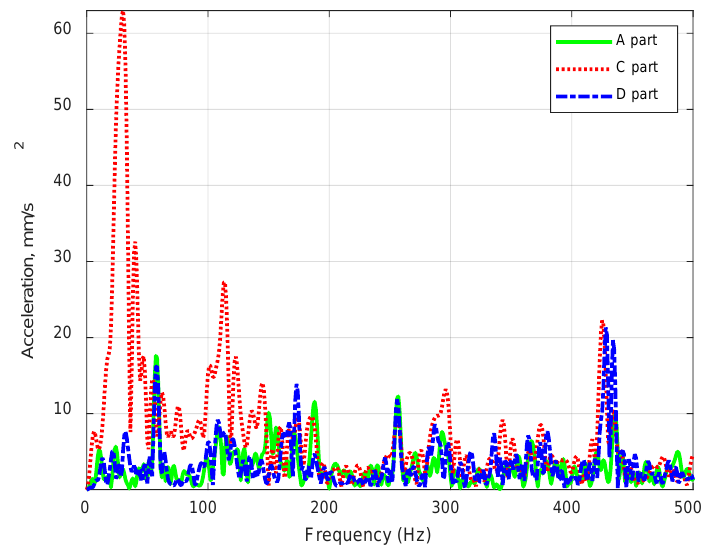
Figure 10. Fast Fourier transform (FFT) for vibrations of periods A, C, and D in Figure 9.